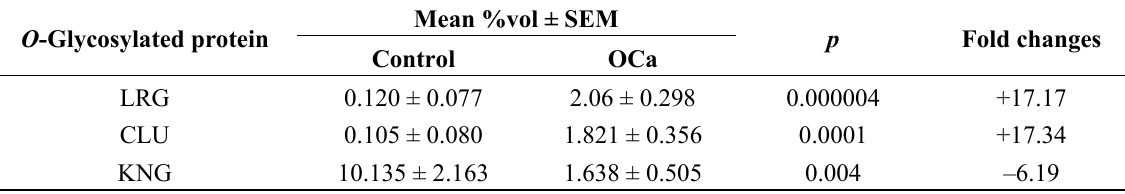
Table 2. Relative expression of aberrantly excreted urinary O -glycosylated proteins. O -Glycosylated protein